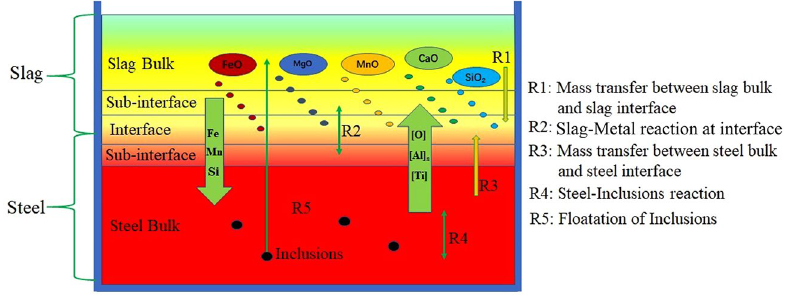
Figure 3. Schematic diagram of slag-metal-inclusions reaction during slag re-oxidation process.